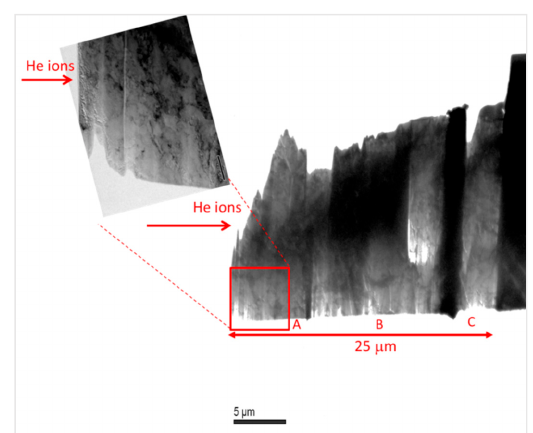
Figure 4. TEM micrograph of the EUROFER97 lamella implanted from 2 to 15 MeV and annealed at 450 °C for 100 h homogeneously thinned along with a detail of the zone A which is the area with the highest He content (716 to 657 appm He).